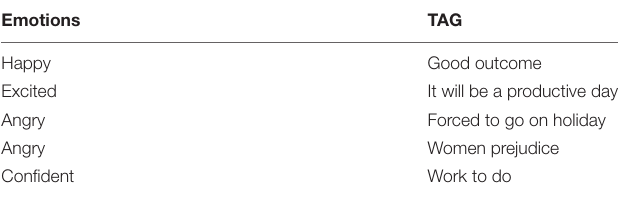
TABLE 2 | Example of emotions and connected tags.